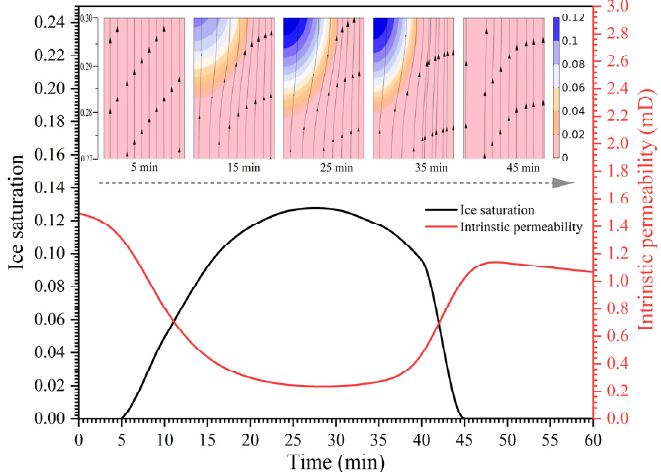
Figure 7. Ice saturation and intrinsic permeability change with time at the outlet boundary, and the distribution of ice saturation adjacent the outlet boundary.